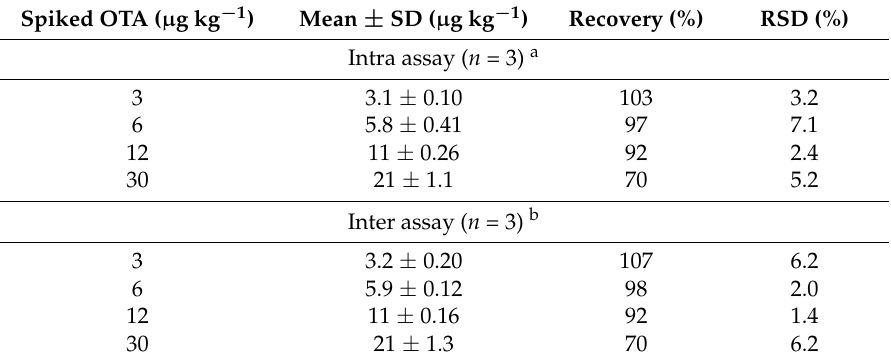
Table 3. Recoveries of OTA from the spiked rice samples by Nb-AP-based one-step ELISA.